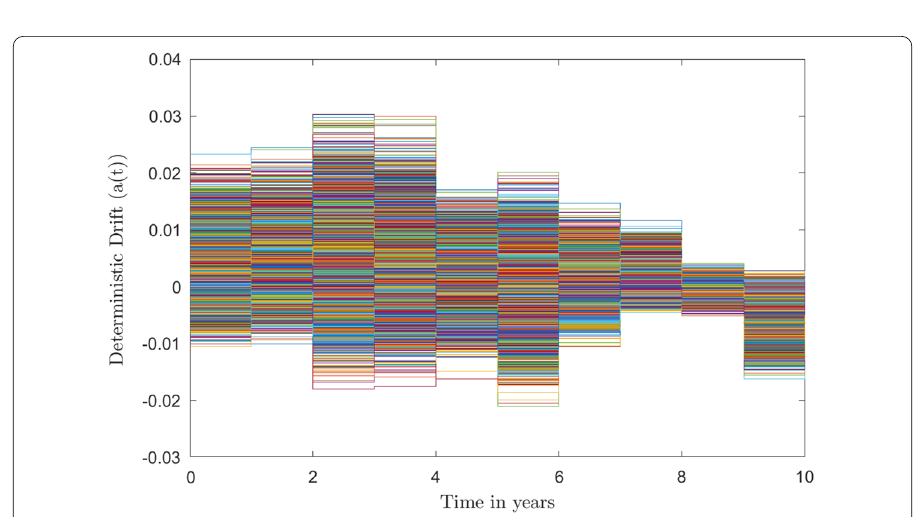
mean reversion b = 0.015. All variable parameters are assumed to be piecewise constants between the tenor points (0 – 3 M ,3 M – 6 M ,6 M – 1 Y ,1 Y – 2 Y ,2 Y – 3 Y ,...,9 Y – 10 Y